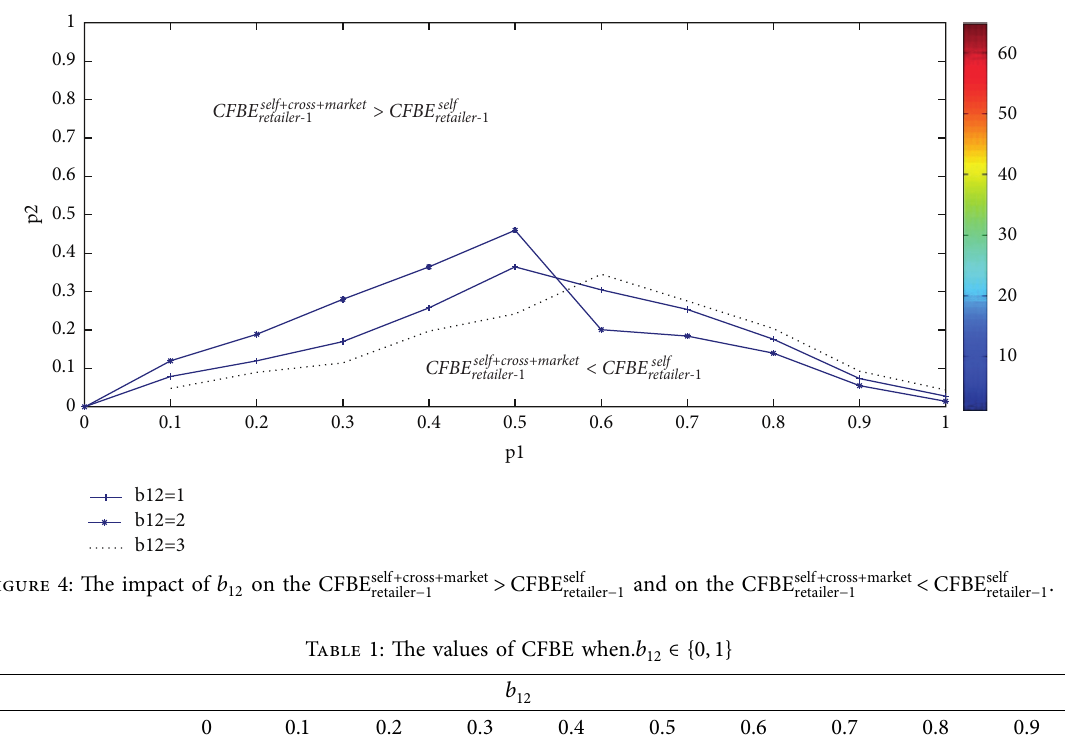
> CFBE self and on the CFBE self + market retailer − 1 retailer − 1